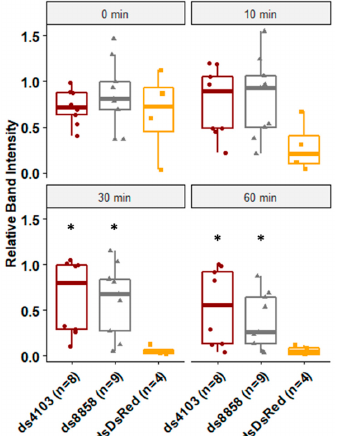
Figure 3. Degradation of long dsRNA after exposure to gut-derived enzymes. The shRNA were expressed in E. coli and fed to Ae. aegypti larvae in brewer’s yeast-supplemented agar feeding pellets for five days at 28 ◦ C. Midguts were dissected and soaked in PBS overnight. The resulting enzyme mix was co-incubated with long dsRNA for 0, 10, 30, or 60 min and resolved by gel electrophoresis. Band intensity was calculated relative to heat-killed controls. Biological replicates are shown as jittered points (number of replicates ranged from four to eight per treatment). Wilcoxon rank-sum p -values less than 0.05 relative to DsRed controls are indicated by *, comparisons are for both ds4103 and ds8858 to dsDsRed for each time point.